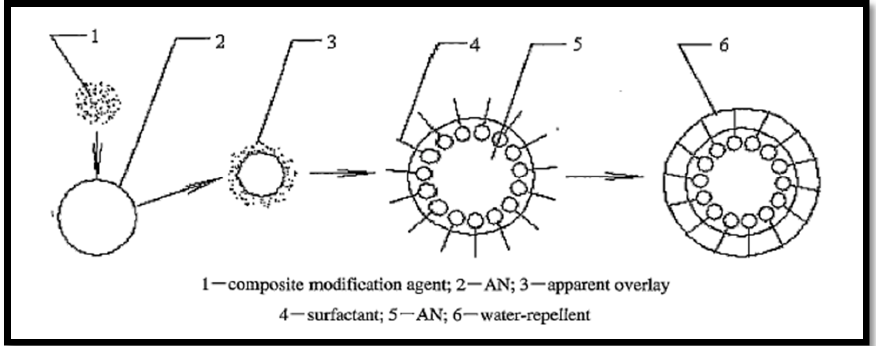
Figure 3. Micro-structure of composite-modified water-resistant powdery AN.